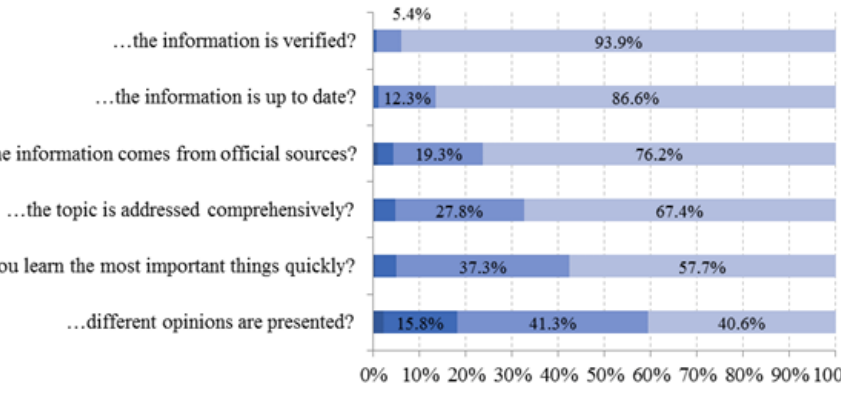
Figure 2. Frequency of use of internet sources for COVID-19 information-seeking ( n = 3041 to 3053).